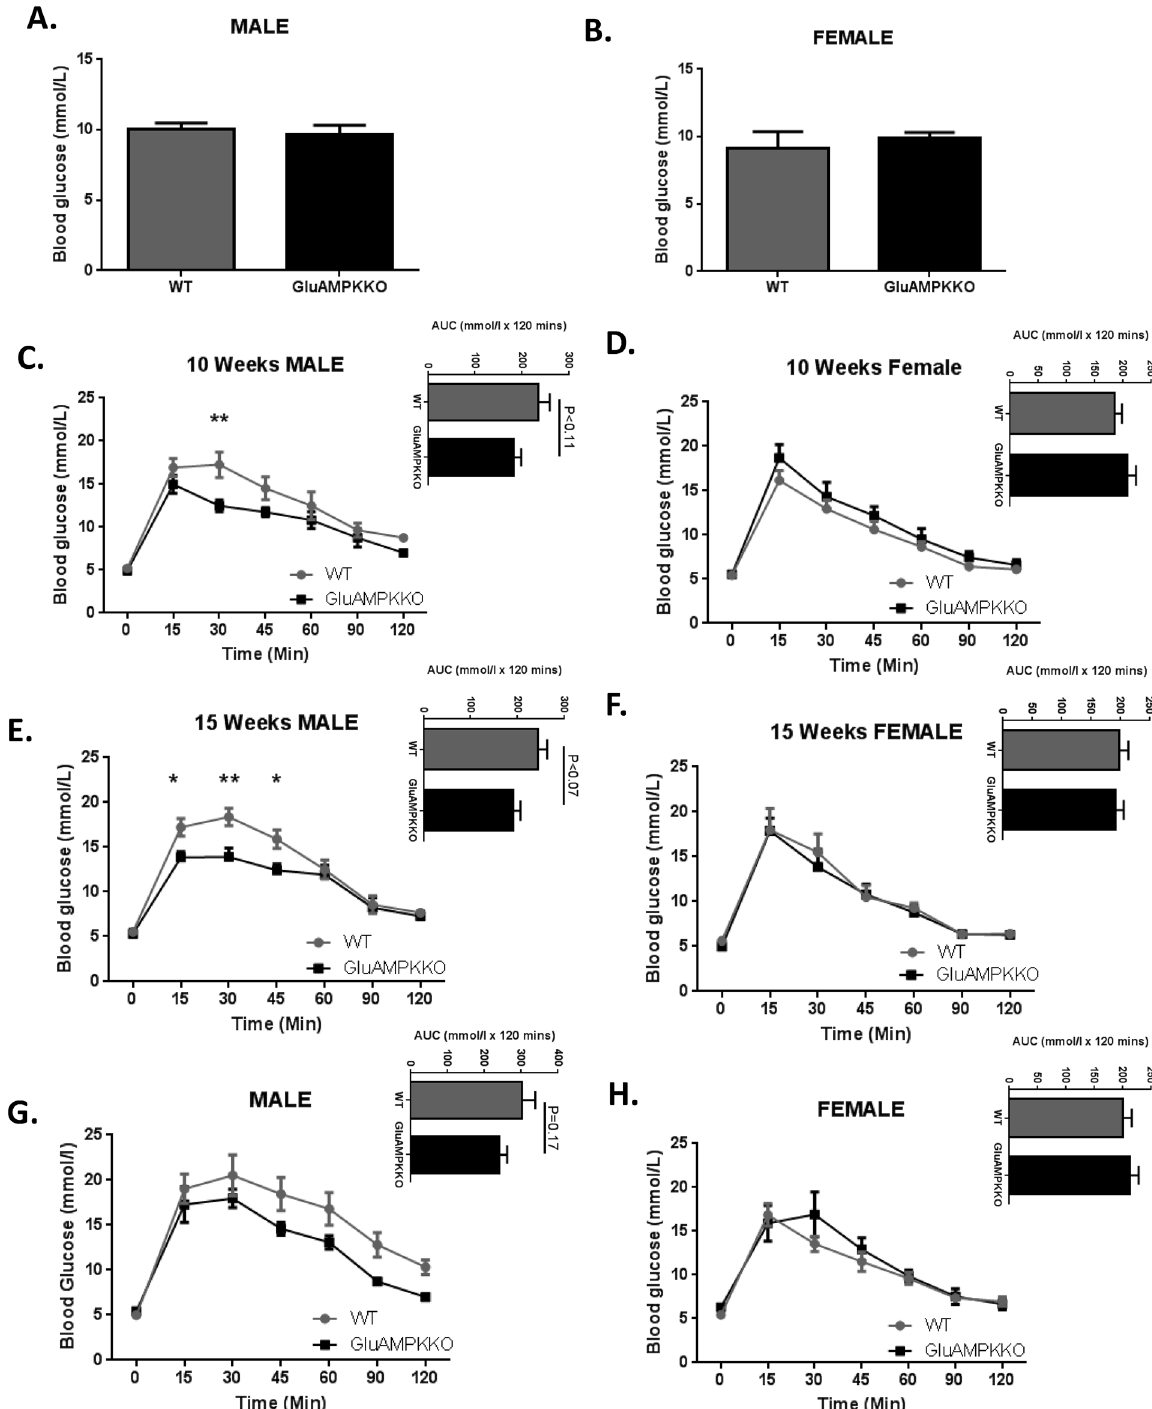
Fig 2. AMPK α 1 and - α 2 deletion in proglucagon expressing cells improves glucose tolerance after oral administration of glucose in male mice but is unchanged after glucose injection. (A,B) Glycaemia was measured in male and female iGluAMPKdKO and WT mice when fed ad libitum . n = 6 – 9 mice/ genotype/sex. (C,D) Glucose was administered using oral gavage (1 g/kg) after mice were fasted overnight and blood glucose levels measured at 0, 15, 30, 45, 60, 90 and 120 min. after glucose administration in 10 week old male and female mice. (E, F) Oral glucose tolerance tests repeated in 15 week old male and female iGluAMPKdKO and WT mice. Area under the curve (AUC) is displayed at the top right of panels. (G,H) IPGTTs were performed on 20 week old male and female mice. n = 5 – 9 mice/sex/genotype, * P < 0.05, ** P < 0.01, by 2-way ANOVA. Data are expressed as means ± SEM.